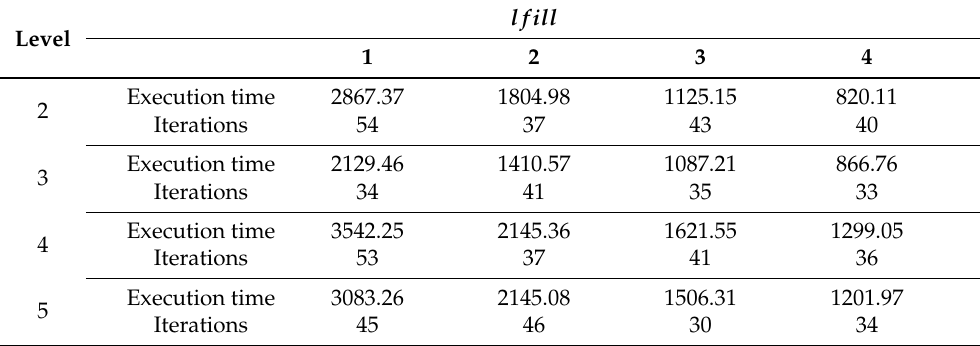
Table 9. Convergence behavior and performance of a parallel V cycle of AGAMG in combination with deflation technique and MGenFAspI with droptol = 0 and l fill = 2 for 3D Poisson model problem with nx = 70.